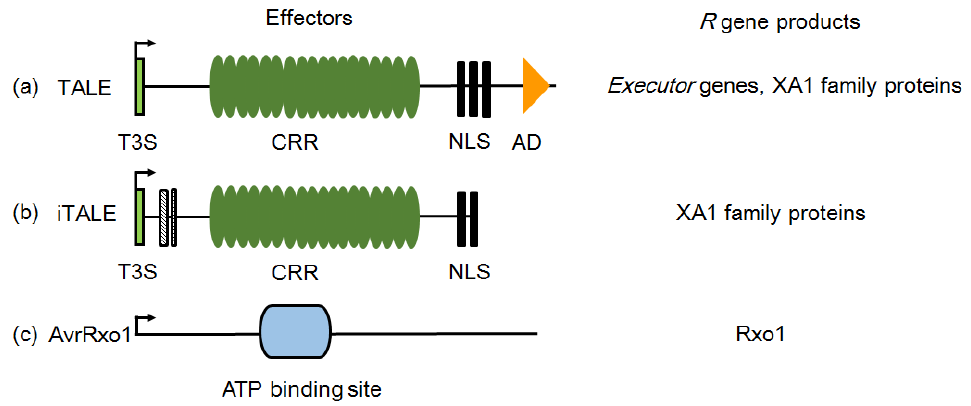
Figure 3. Structural features of identified effector proteins participating in induction or suppression of major R gene resistances. ( a ) The typical structure of TALEs. TALEs contain an N-terminal type III secretion and translocation signal (T3S), a specific central repeat region (CRR), three nuclear localization signals (NLS), and a C-terminal transcription activation domain (AD). TALEs play multiple roles in rice– X. oryzae interaction and can be recognized by executor and Xa1 family genes. ( b ) The structure of type-A iTALEs. iTALEs are truncated variants of TALEs. Boxes with stripes represent deletions. In X . oryzae , iTALEs are prevalent inhibitors of resistance of Xa1 family genes. The different structures endow TALE and iTALE with opposite functions. ( c ) AvrRxo1 is similar to the zeta toxin protein, and an ATP-binding site exists in the central region. The targeted R gene products involved in susceptibility or resistance induced by the effectors are shown on the right.